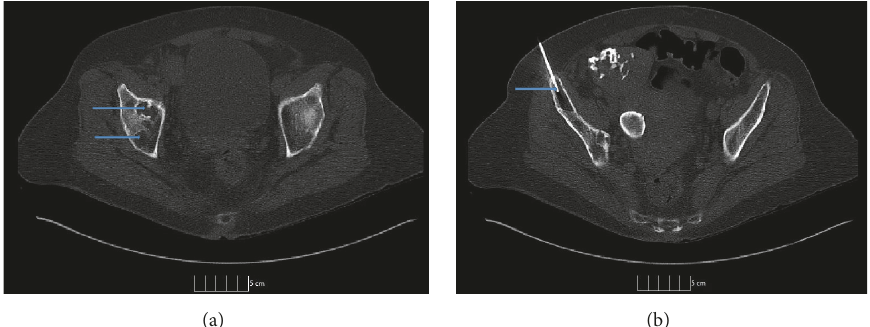
Figure 3: CT imaging of the pelvis showing cystic osteolytic (exceptional) bony lesion with a sclerotic rim within the (a) right acetabulum and (b) right iliac crest with FNAC needle.